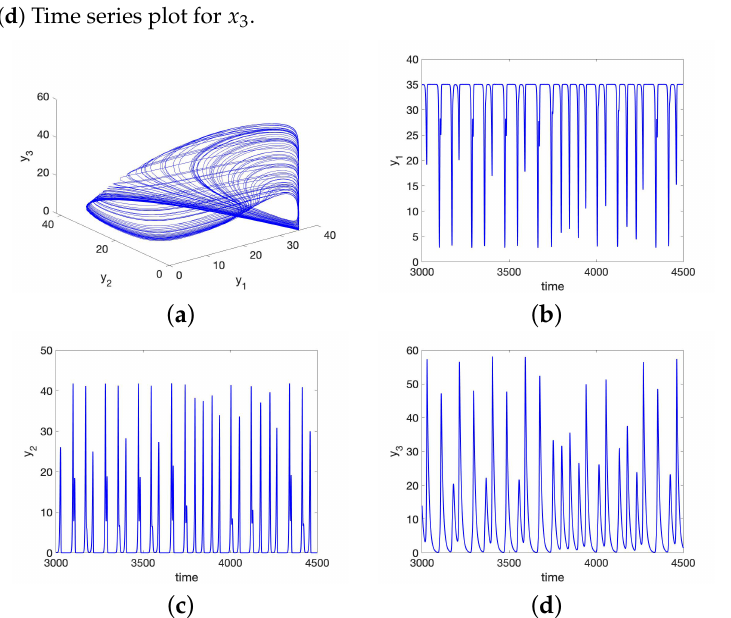
Figure 2. Chaotic dynamics with initial data [ y 1 ( 0 ) , y 2 ( 0 ) , y 3 ( 0 )] = [ 10,10,10 ] in HP model. ( a ) Phase diagram showing chaotic attractor in HP model. ( b ) Time series plot for y 1 . ( c ) Time series plot for y 2 . ( d ) Time series plot for y 3